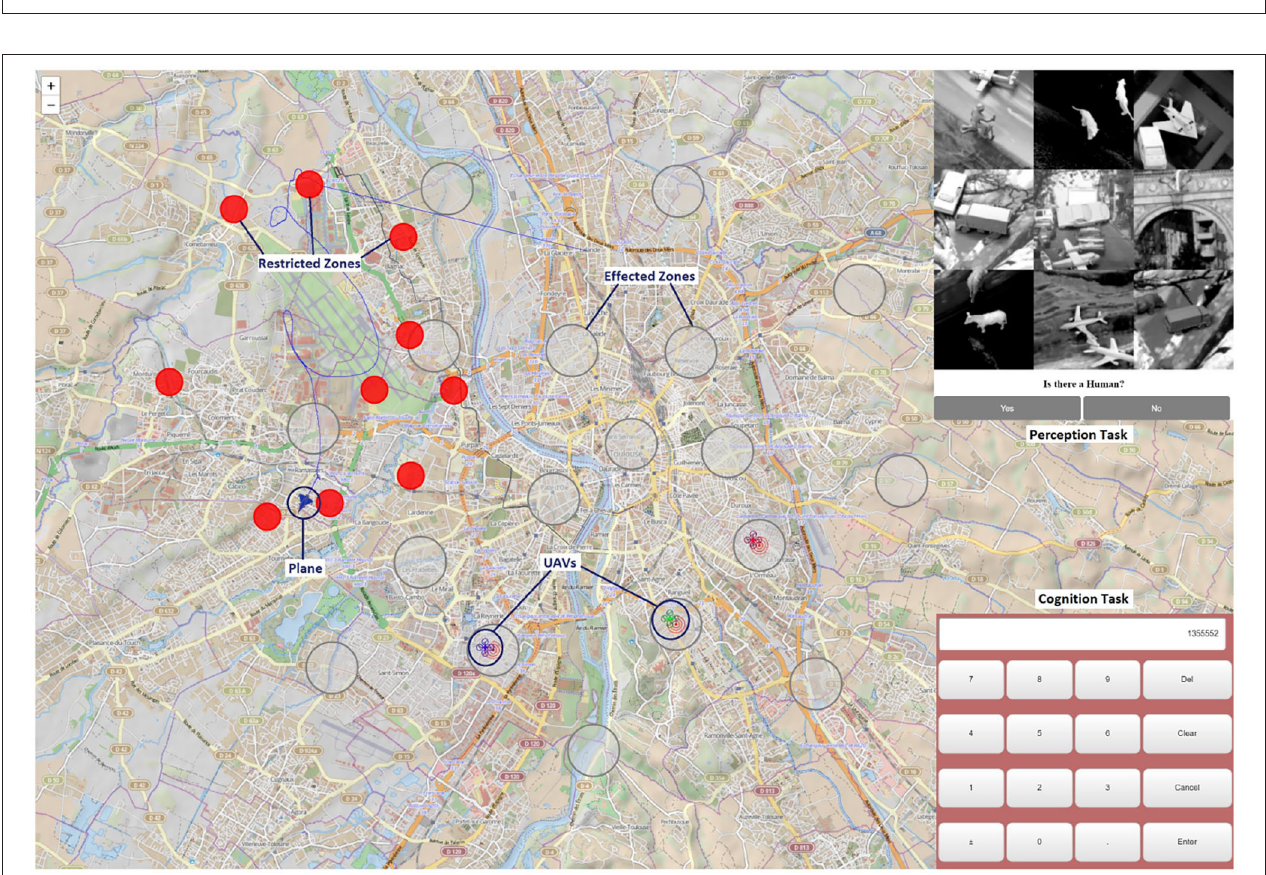
FIGURE 2 | Aerofly simulatior and U-track application screens setup.